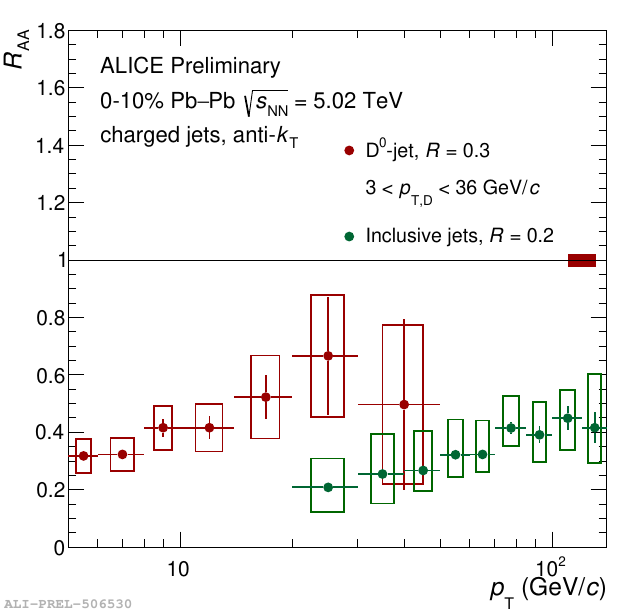
Figure 3. Nuclear modification factor of D 0 -jets (red markers) and inclusive charged-particle jets (green markers) in central (0–10%) Pb–Pb collisions at √ s NN = 5 . 02 TeV. Statistical and systematic uncer- tainties are, respectively, presented as vertical lines and